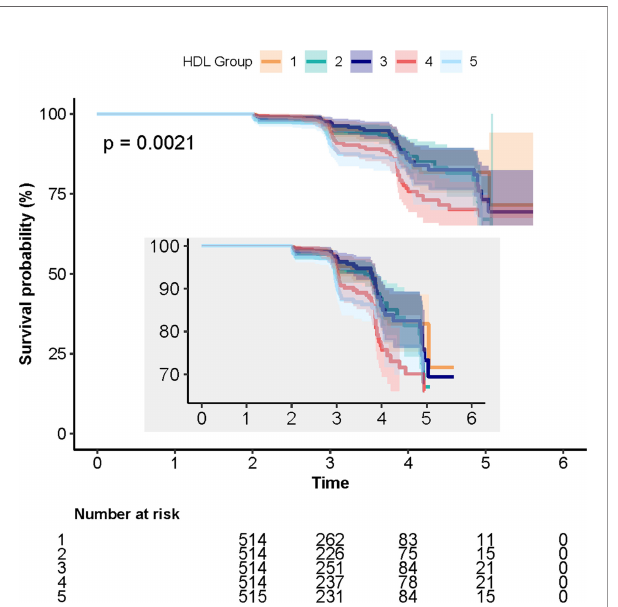
FIGURE 2 | Spline graphical representation of the relationship between triglyceride to high-density lipoprotein cholesterol (TG/HDL-C) ratio and incident T2DM in the multivariable-adjusted model (model II). The restricted cubic splines showed a dose – response relationship between TG/HDL-C ratio variability and incident diabetes. With the increase of TG/HDL-C ratio, the hazard ratio (HR) of incident T2DM gradually increased and showed a curvilinear